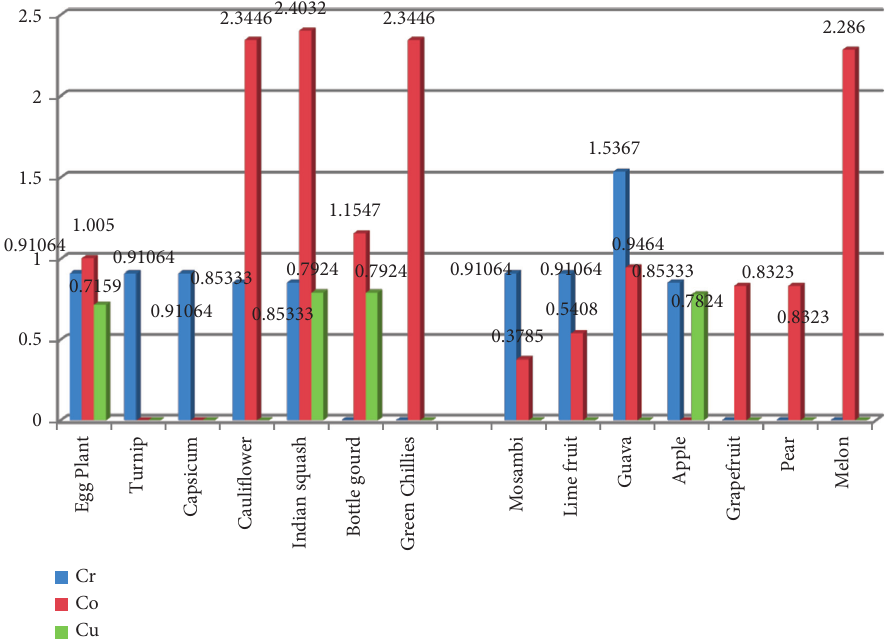
Figure 3: Bioaccumulation factor of heavy